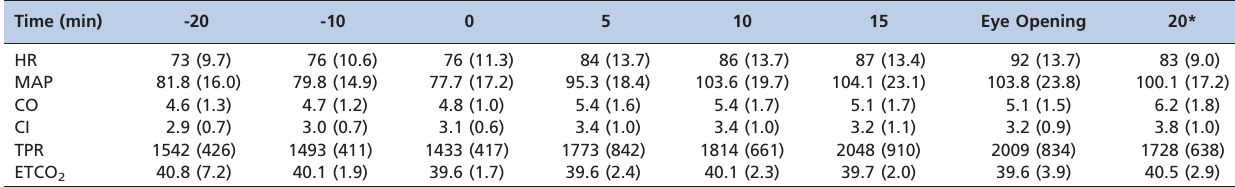
Table 3 - Hemodynamic and ventilatory variables during emergence (N=